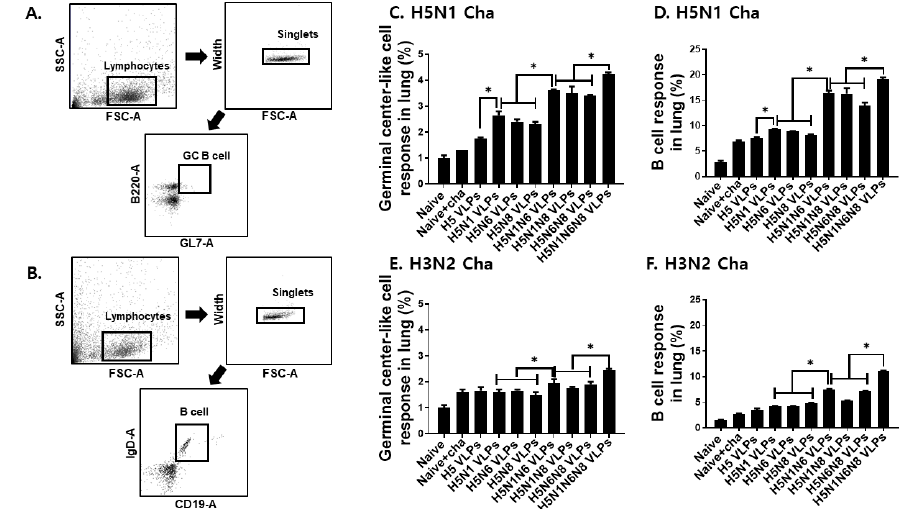
Figure 5. Mice were immunized twice with VLPs and challenge infected with a lethal dose of H5N1 or H3N2 influenza viruses. Lungs were isolated from mice 4 days post-challenge infection and lung cells were stained with B220, GL7, CD19, and IgD. Single cell populations of lung cells were gated to assess proliferation of GC-like B cells and B cells ( A , B ). Germinal center-like cell ( C , E ) and B cell ( D , F ) populations were determined by flow cytometry. All data are expressed as mean ± SD (* p <